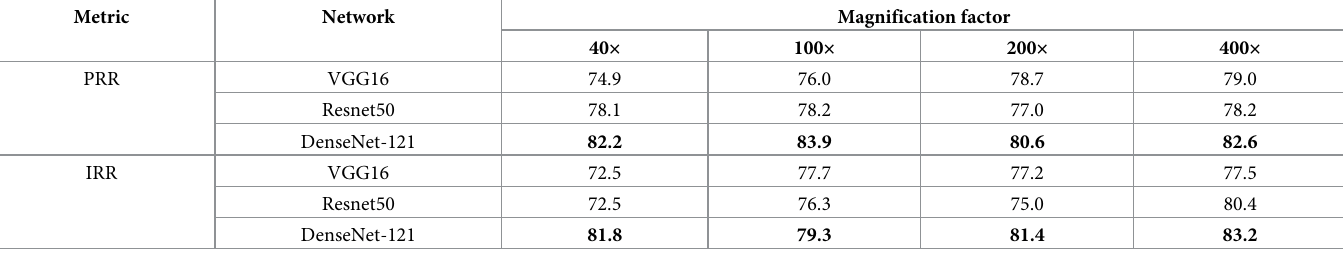
Table 2. Performance of BC classification using VGG16, Resnet50 and DenseNet-121. The best performance is highlighted by boldface.